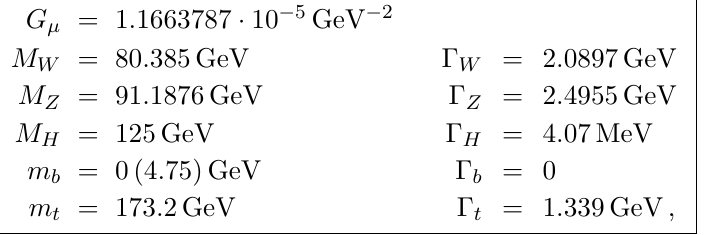
b depends on the employed